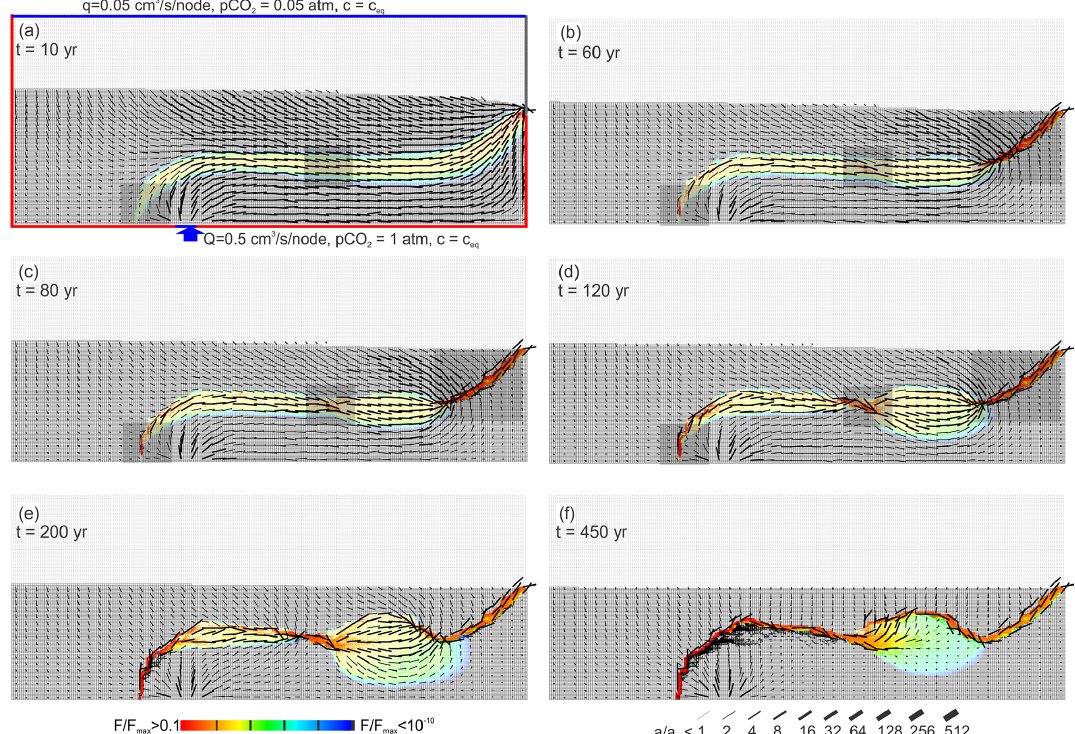
Figure 19. Patterns of flow lines for the standard